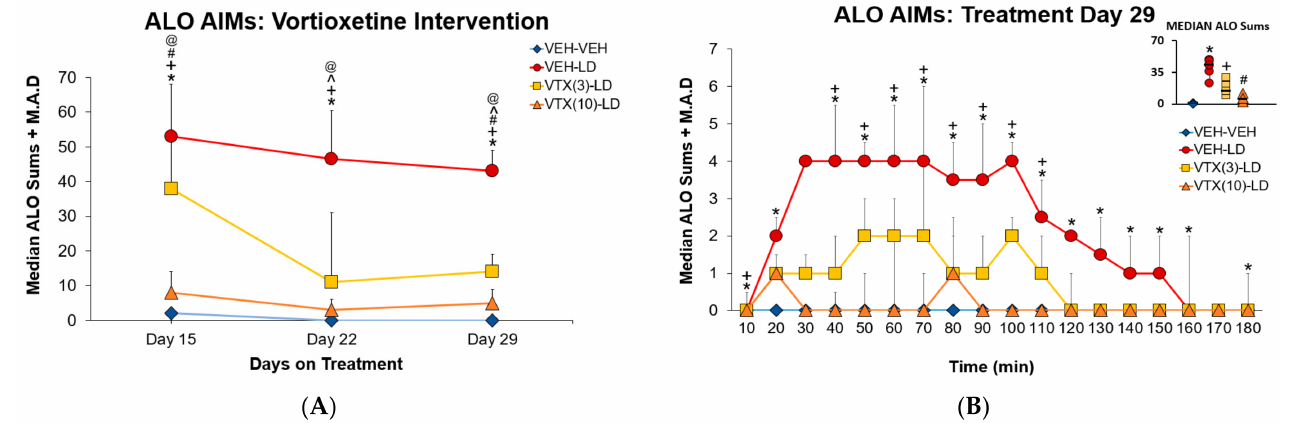
Figure 3. Experiment 1: Sub-Chronic Vortioxetine Intervention in Dyskinetic Rats. Rats (N = 26) were treated with vortioxetine (VTX; 3, 10 mg/kg, s.c.) or vehicle (VEH) 5 min prior to administration of L-DOPA (LD; 6 mg/kg, s.c.) or VEH for 14 consecutive days following a 2 week daily L-DOPA only regimen in a between-subjects design (n = 6 VEH-VEH, n = 6 VEH-LD; n = 7 VTX(3)-LD; n = 7 VTX(10)-LD). Axial, limb, and orolingual (ALO) abnormal involuntary movements were observed over a 3 h time course every 10 min following the L-DOPA injection. To determine effects over the 2-week testing period, ( A ) weekly ALO AIMs sums are shown and were expressed as median and mean absolute deviation (M.A.D.). To examine the time-course of effects on the final day of testing ( B ), individual timepoints are shown for each group’s ALO AIMs. Significant differences in ALO AIMs between treatments on each day ( A ) and across time course ( B ) were determined using non-parametric Kruskal–Wallis ANOVAs with Mann–Whitney U’s post hoc tests. * p < 0.05 VEH-VEH vs. VEH-LD; + p < 0.05 VEH-VEH vs. VTX(3)-LD; # p < 0.05 VEH-VEH vs. VTX(10)-LD;